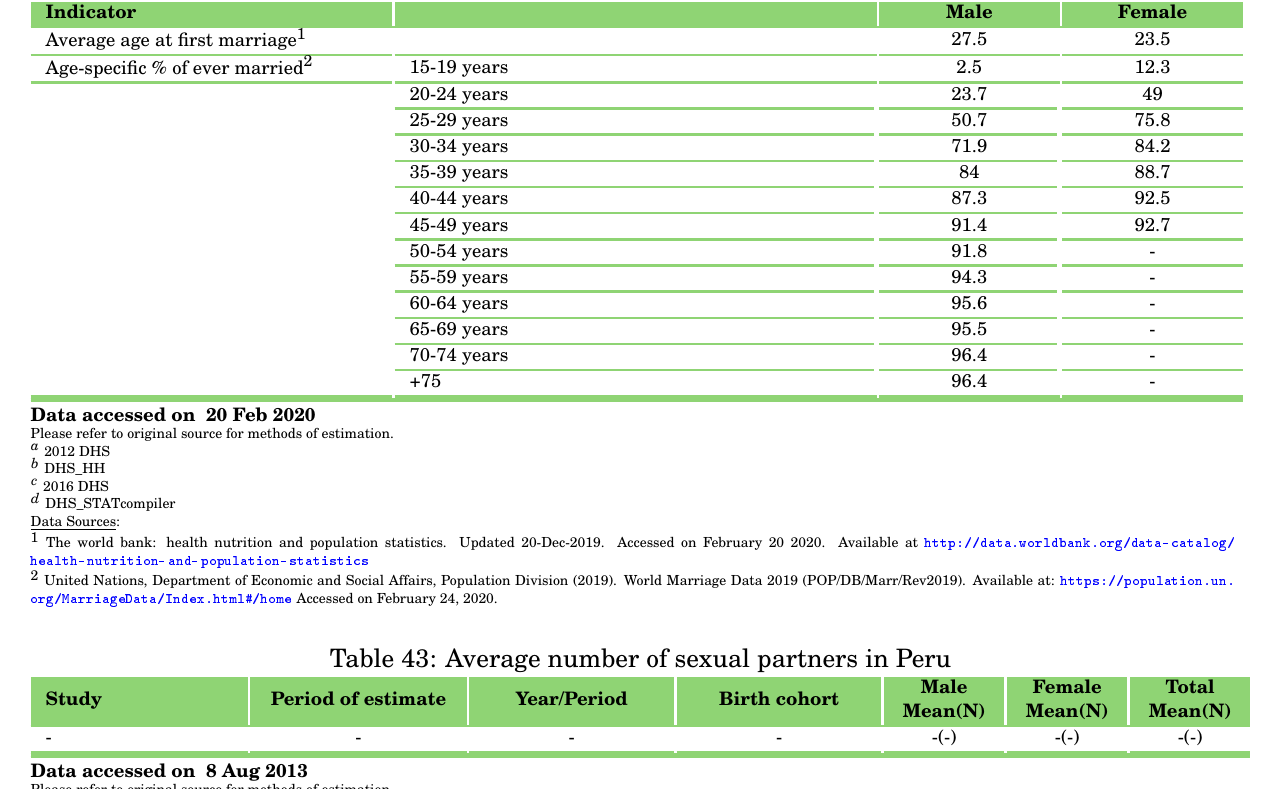
Table 42: Marriage patterns in Peru